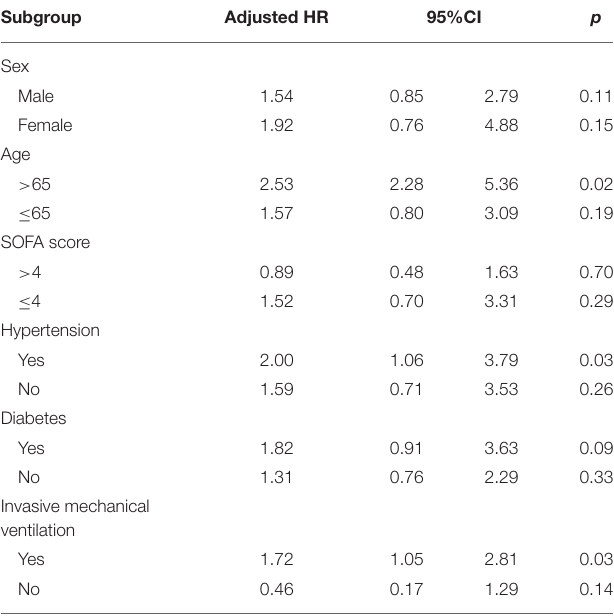
TABLE 2 | Multivariate Cox proportional hazards regression model to explore convalescent plasma therapy associated with 60-day mortality in severe and life-threatening coronavirus disease 2019 (COVID-19).